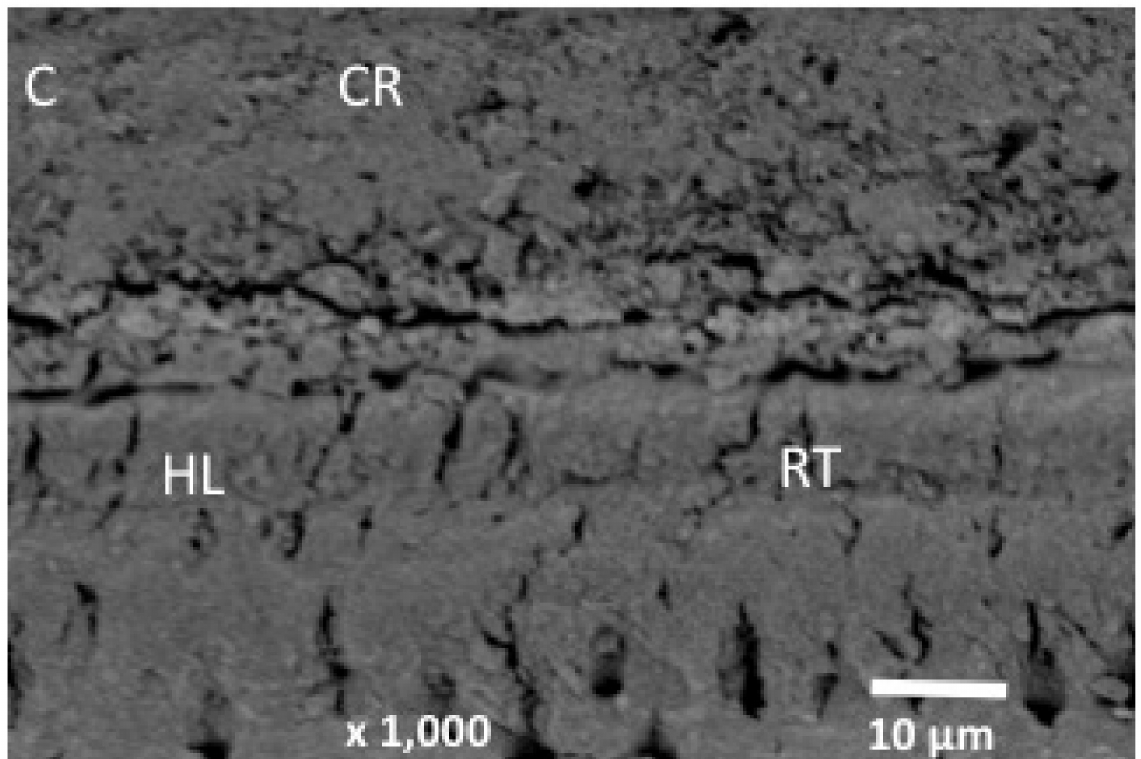
Figure 3. SEM images of the bonded resin and dentin interface using ( A ) control dentin adhesive, ( B ) 5 wt.% and ( C ) 10 wt.% tricalcium phosphate dental adhesive. All specimens formed a uniform adhesive layer that bonded well to the composite resin (CR). The formation of a hybrid layer (HL) was observed along with resin tags (RT). Gaps within the hybrid layer and the adhesive can also be observed in the unmodified dentin adhesive specimen. 5 wt.% adhesive exhibited longer and more numerous resin tags, with the formation of fewer gaps within the hybrid layer. ( B ) The 10 wt.% presented a uniform hybrid layer with gaps at the resin–dentin joint and shorter resin